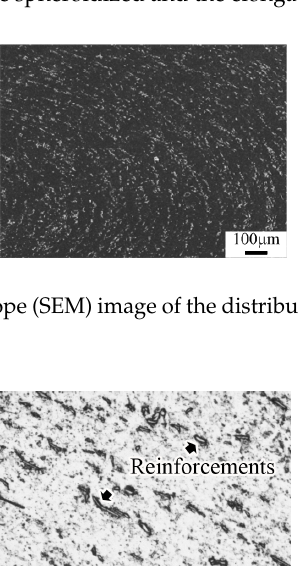
Figure 6. OM image of the distribution of the reinforcements in alloy A after isothermal compression.